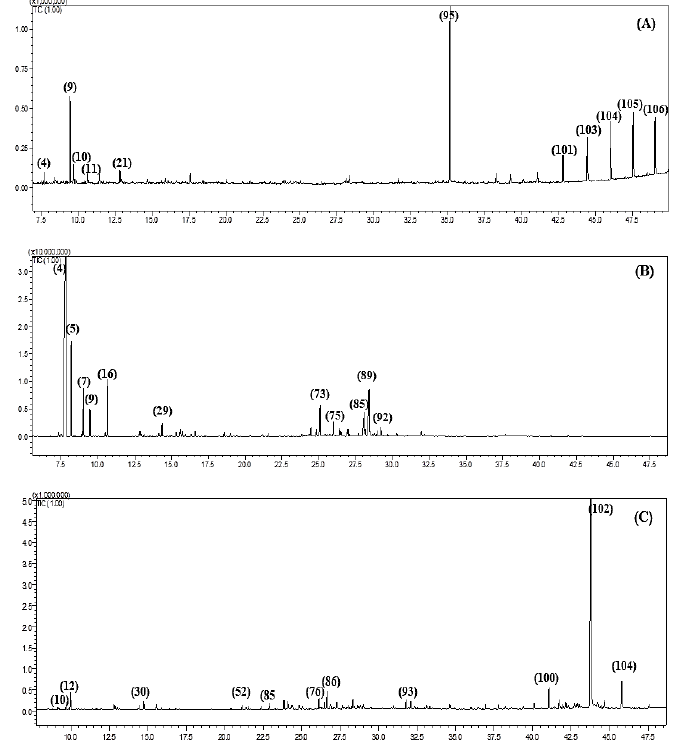
Figure 2. GC-MS chromatograms of F. samarcandica ( A ), F. tenuisecta ( B ) and F. varia ( C ).